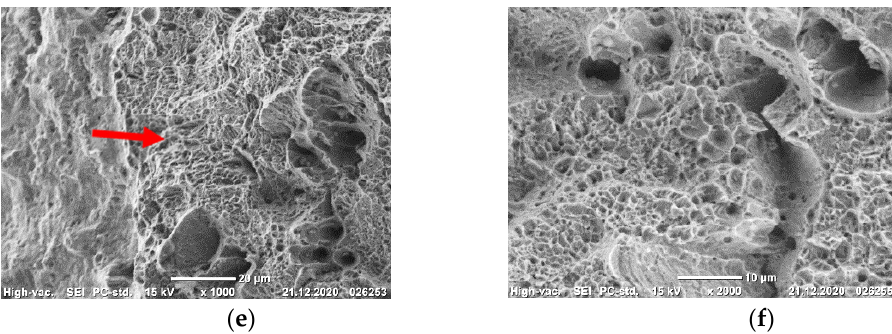
Figure 2. Fracture surface microrelief at the fracture nucleus ( a , c , e ) and in the static fracture region ( b , d , f ) of the CG ( c , d ), and UFG ( a , b , e , f ) specimens from the steel tested for static crack resistance at 20 ° С ( a , b ) and − 196 ° С ( c – f ). The arrows indicate the nucleus of static fracture. ( a )—×500; ( b , c , e )—×1000; ( d , f )—×2000.